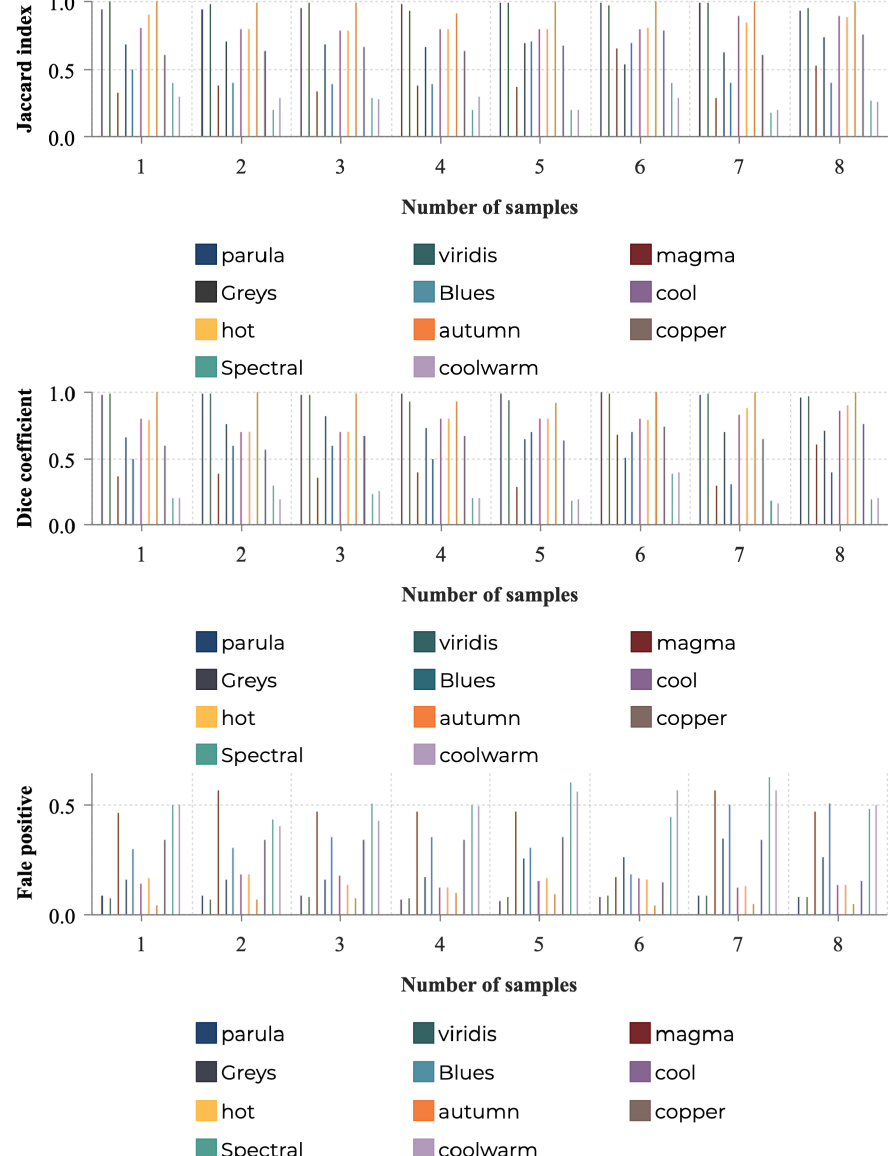
Figure 5. The quantitative evaluation of the 11 colormaps over 8 samples [8]. The first subfig- ure: Jaccard index (the higher value, the better performance); Middle subfigure: Dice coefficient (the higher value, the better performance); Third subfigure: false positive (the lower value, the better